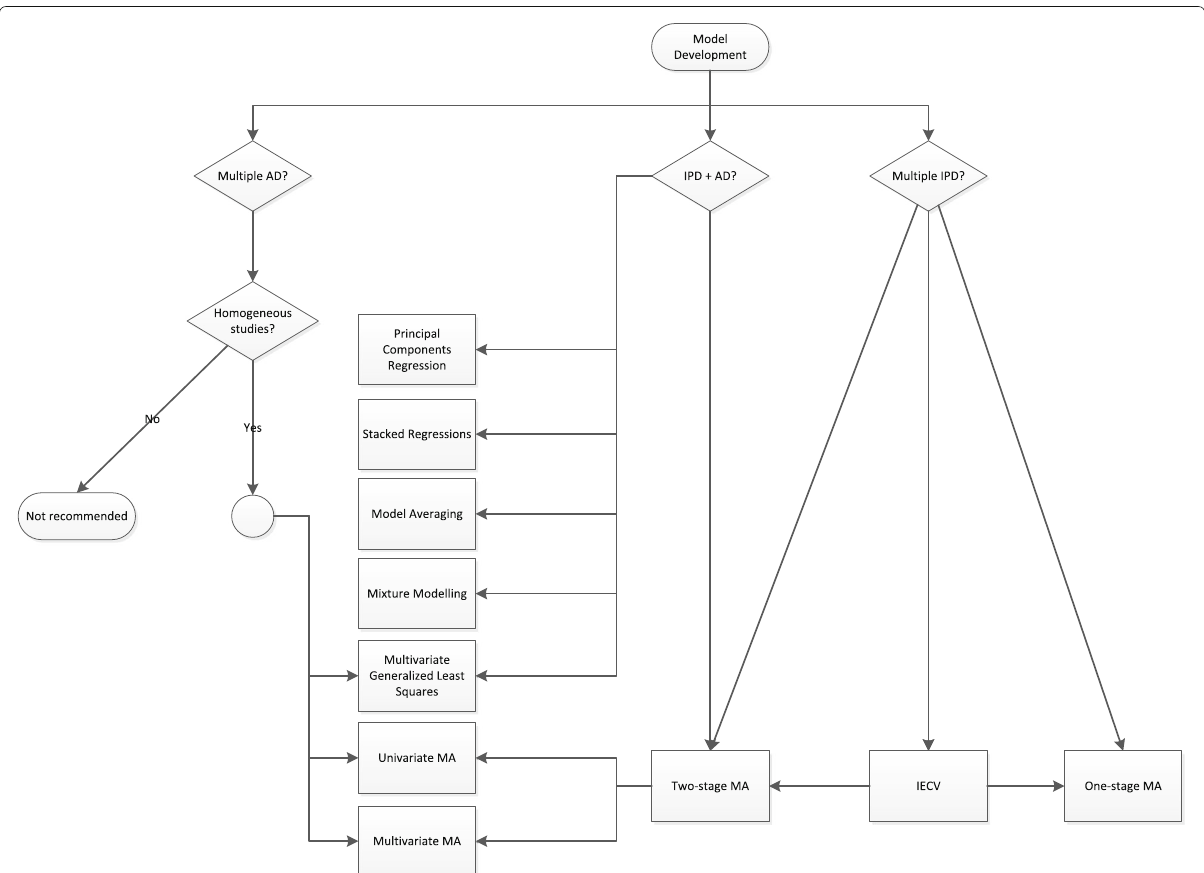
Fig. 3 Available methods for quantitative synthesis during prognostic model development. Abbreviations: MA, meta-analysis; IECV, internal-external cross-validation; AD, aggregate data; IPD, individual participant data